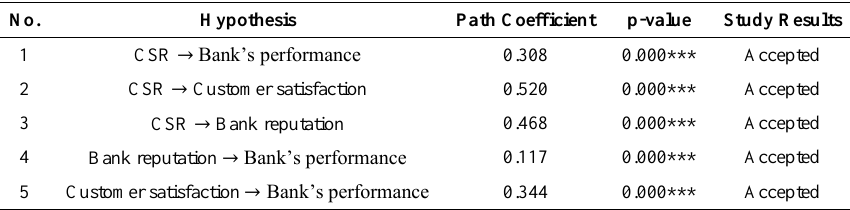
Table 9. Summary of hypothesis testing